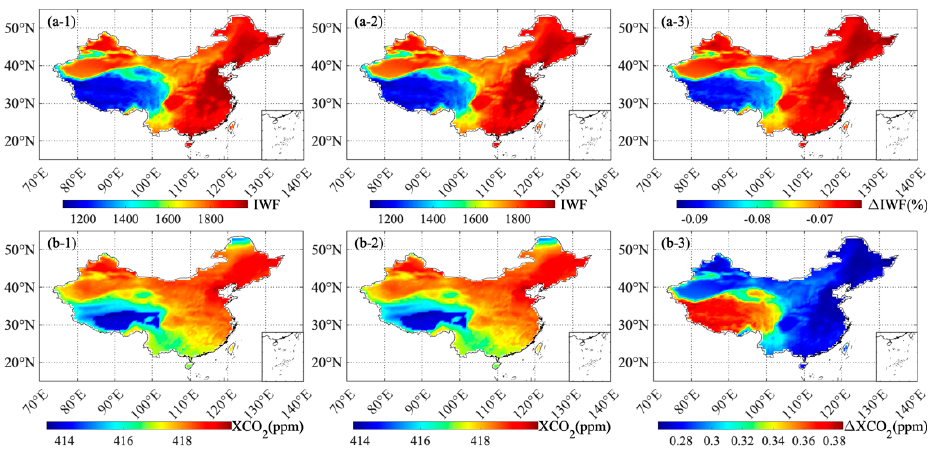
Figure 12. Comparison of the IWF and XCO 2 results on 10 April 2021: ( a-1 ) IWF results with Doppler shift; ( a-2 ) IWF results without Doppler shift; ( a-3 ) relative difference (%) in IWF between the above two IWF results; panel ( b ) is same as panel ( a ) except for XCO 2 .